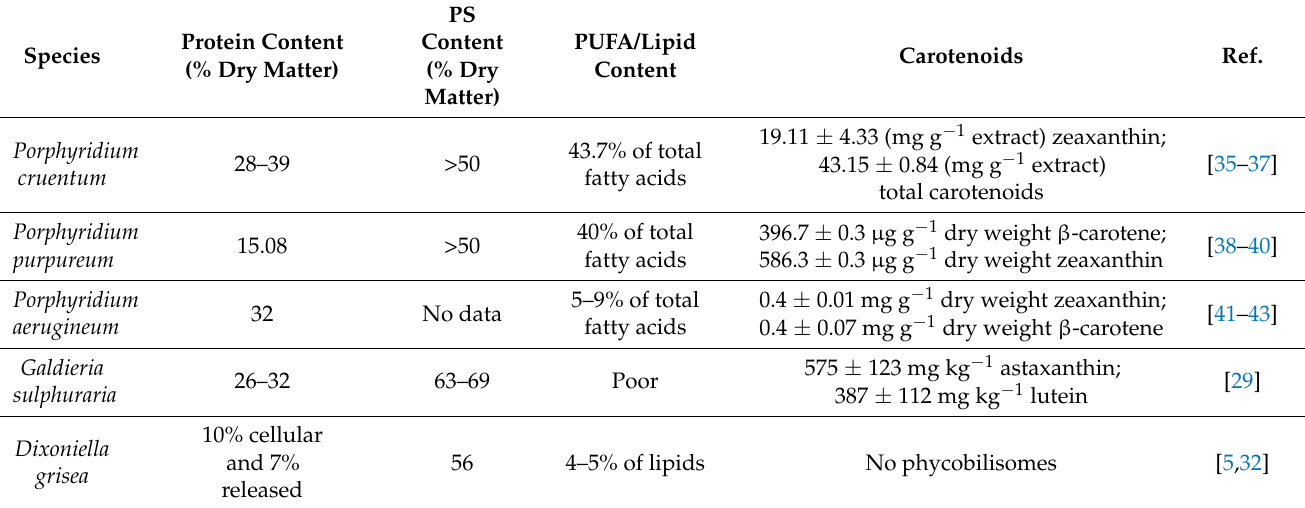
Table 1. Protein, polysaccharide, PUFA/lipid, and carotenoid content of red microalgae